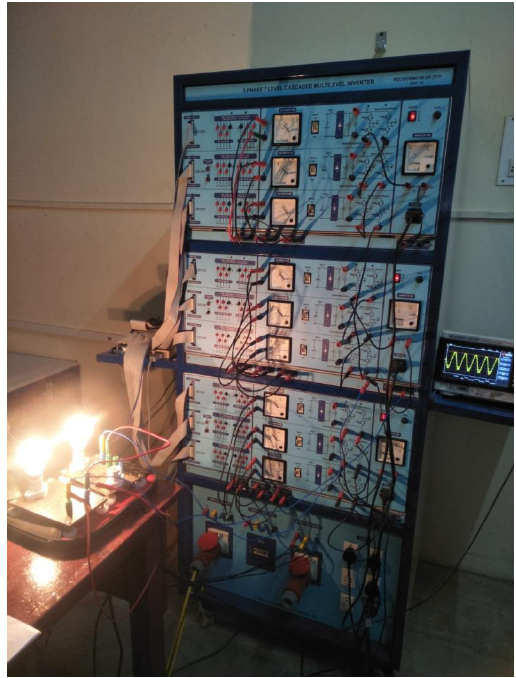
Figure 52. Hardware setup for seven-level cascade inverter at Shanmugha Arts, Science, Technology